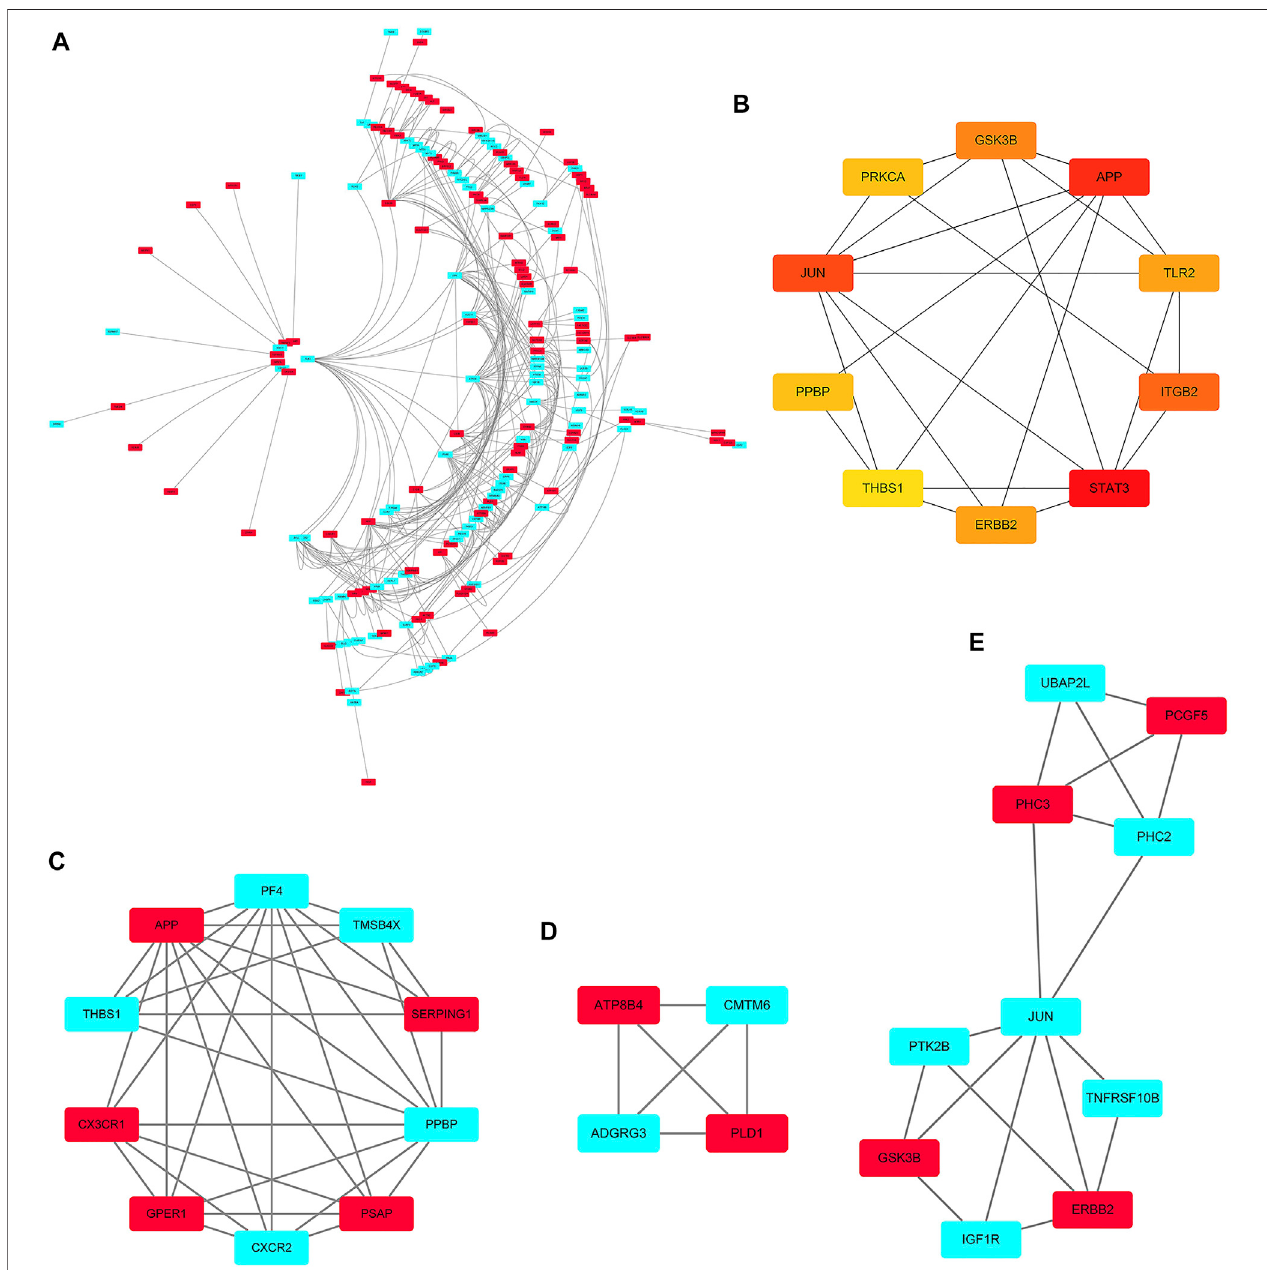
FIGURE 5 | PPI network. (A) The PPI networks of 249 DEGs (153 down-regulated DEGs and 96 down-regulated DEGs); (B) The top 10 genes derived from the degree method are chosen using the CytoHubba plugin and the more forward ranking is represented by a redder color; (C – E) The top 3 signi fi cant modules obtained from the PPI network with a high score ( ≥ 4). Red: represent down-regulated DEGs; Blue: represent up-regulated DEGs.